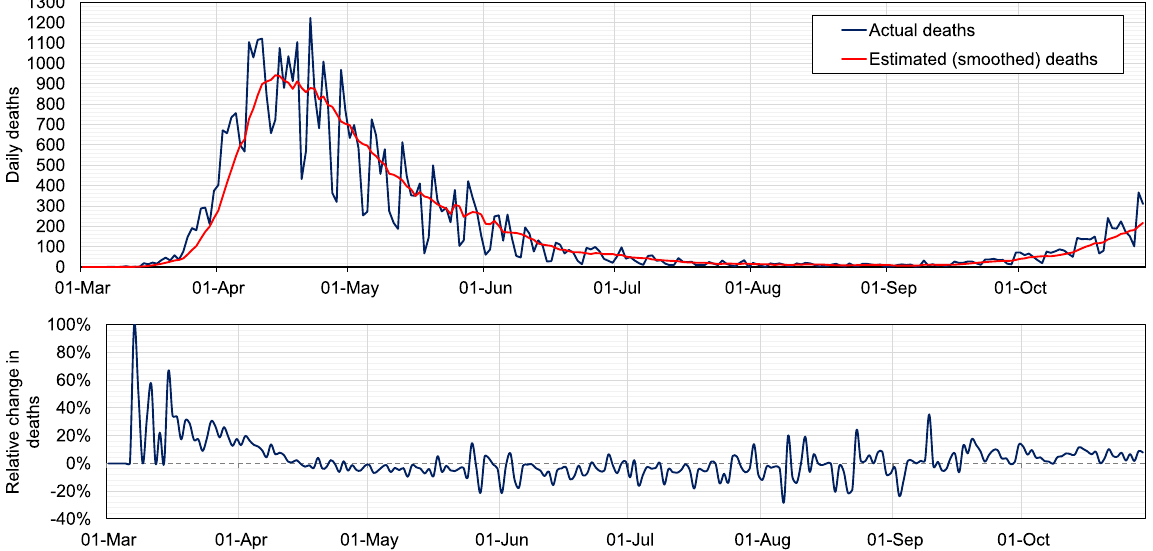
Fig. 7. The daily deaths (top) and the relative shift in deaths (bottom) in the United Kingdom.